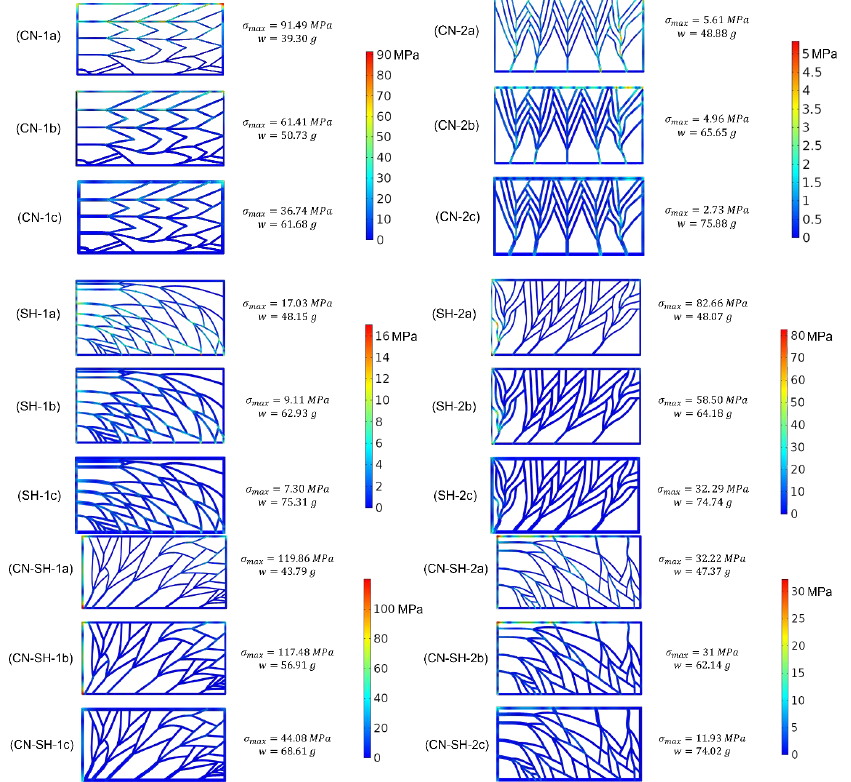
Figure 10. von Mises contours of Experiments 1, 3, and 9 for each load case and PSLs ’ direction. The main effect plot for the six structures is shown in Figures 11 – 16. The influence of each factor on the response function was analyzed by the main effect plot, respectively, for the maximum value of the von Mises stress (Figures 11a – 16a) and the structure weight (Figures 11b – 16b). For the main effect plot, the slope justified the effect of each parameter. Parameters having the highest inclination had a greater effect, while parameters having a horizontal plot had a minimal effect on the response function.